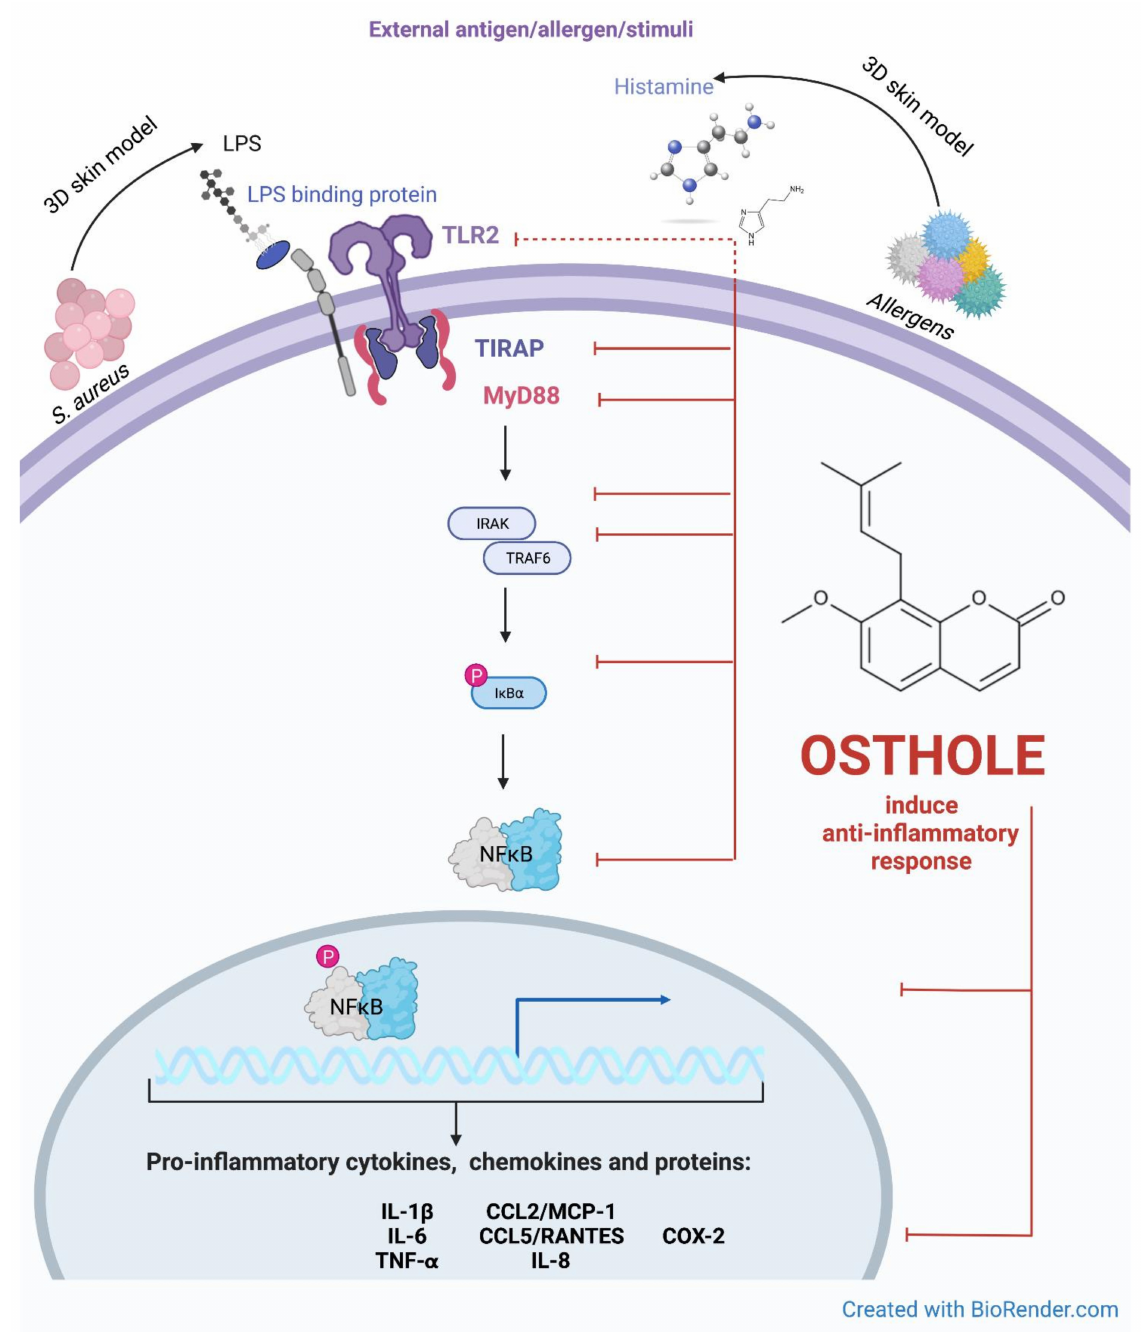
Figure 8. Putative pathway for the inhibitory effect of osthole on the TLR-2 signaling pathway. The interplay between TLR2-mediated signaling and induction of expression of secreted cytokines, chemokines and proteins during stimulation with histamine and LPS in 3D skin model. Created with